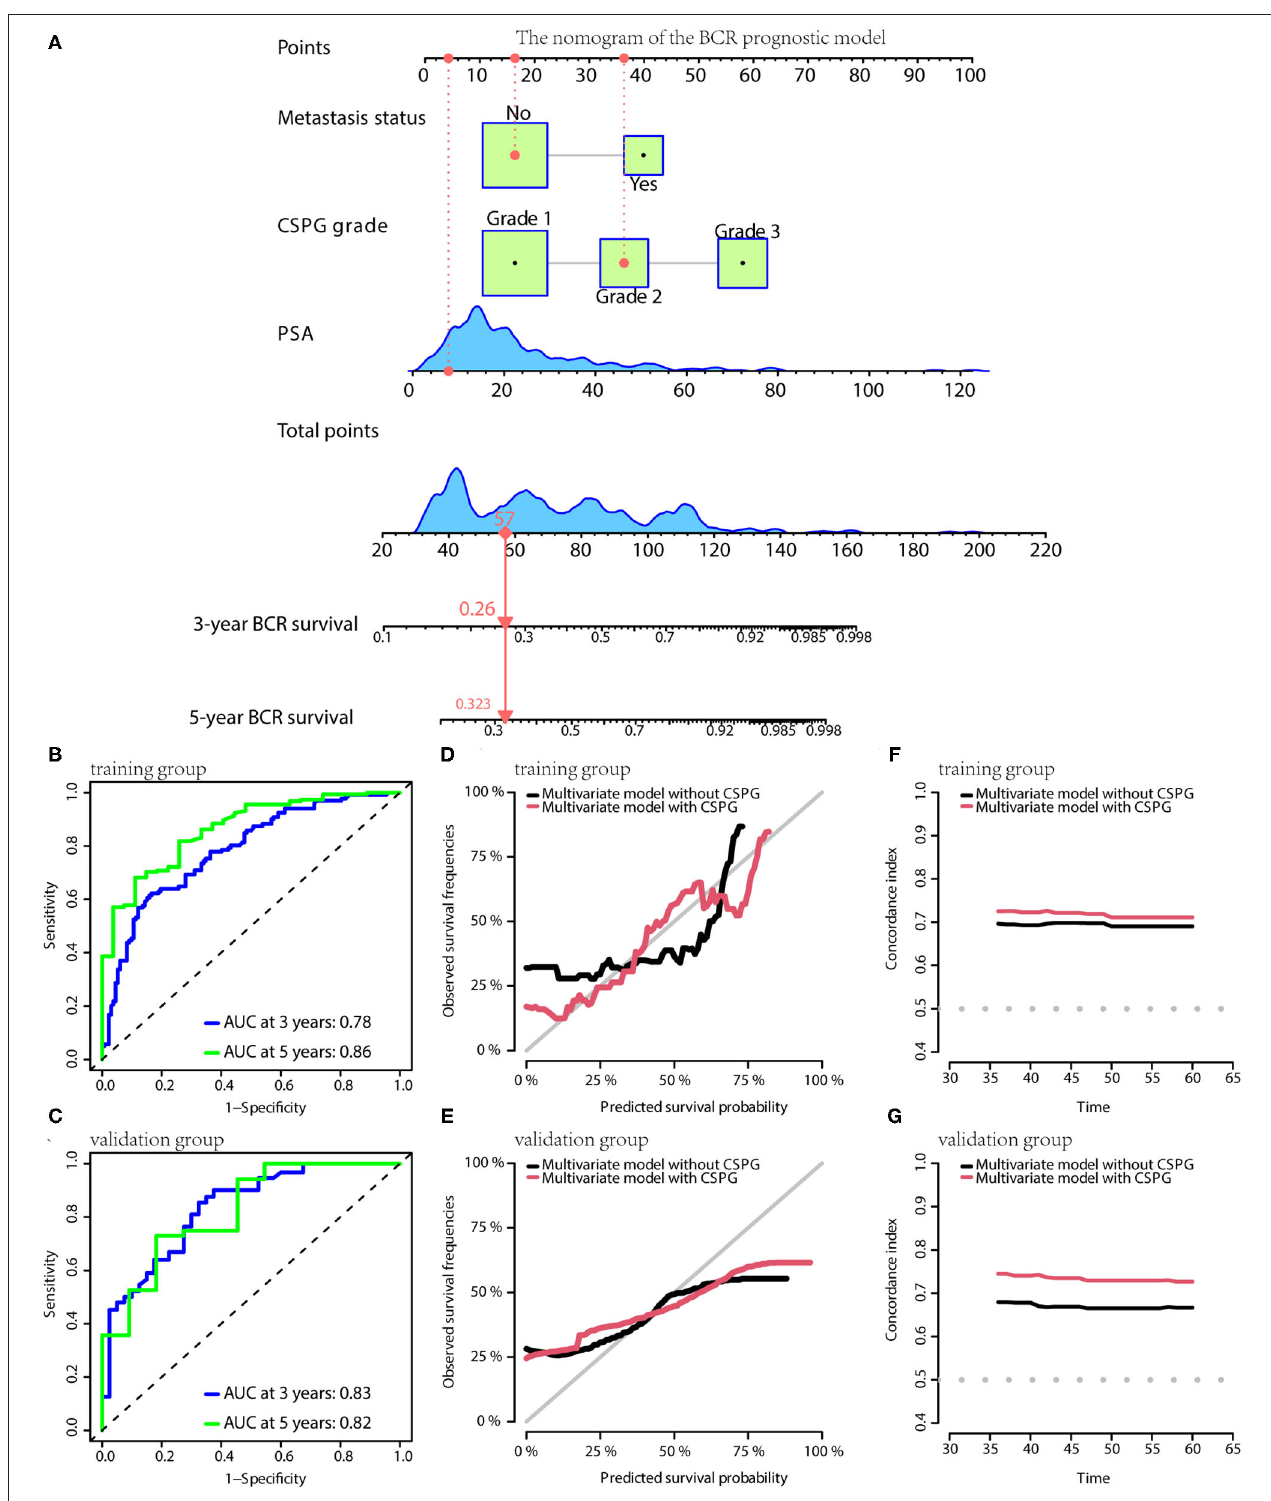
FIGURE 5 | The BCR prognostic model possesses the accuracy and robustness. (A) Nomogram of the BCR prognostic model with information of one patient as an example. (B) Time-dependent receiver operating characteristic (tdROC) curves show the model has a good predictive accuracy at 3 and 5 years in the training group (B) and in the validation group (C) . The calibration curves indicate that the model using combined cysteine rich secretory protein 3 (CRISP3) and serine peptidase inhibitor Kazal type 1 (SPINK1) prognostic grade (CSPG) predicts prognosis more accurately in the training group (D) and in the validation group (E) . The line chart shows the model using CSPG has higher C-index values in the training group (F) and in the validation group (G) . BCR, biochemical recurrence.